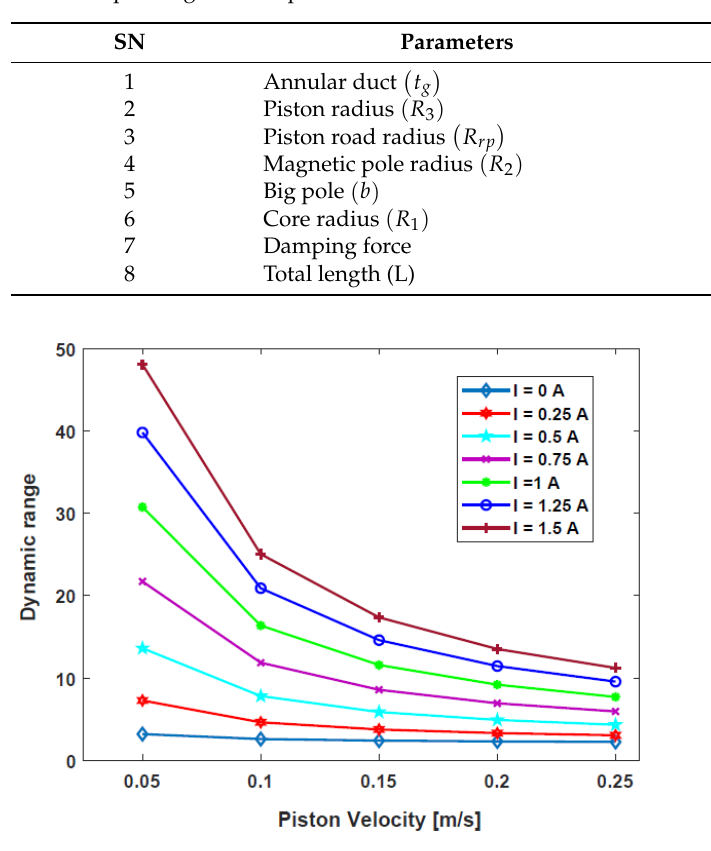
Figure 8. Dynamic ranges of the HARMRD under various excitation velocities.